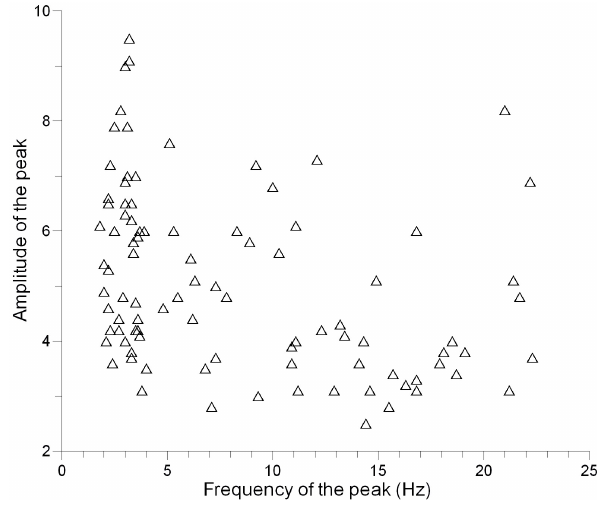
Fig. 5. Amplitude vs. frequency graph of HVSR